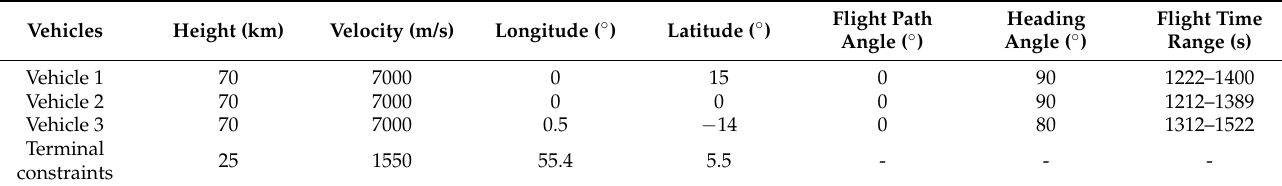
Table 2. The different positions and radii of multiple no-fly zones. Table 3. The initial conditions of the time cooperative